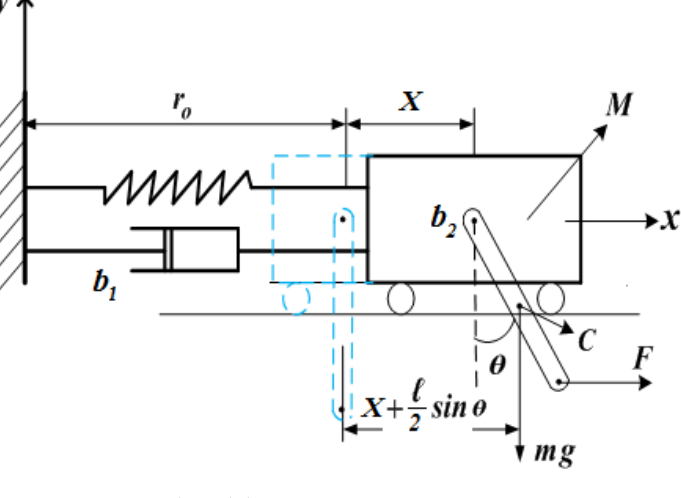
Figure 1. Dynamical model.